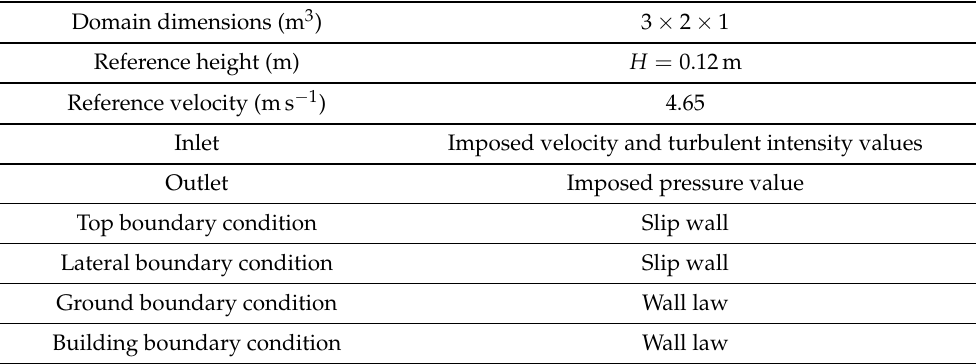
Table 3. Model settings for the street canyon dispersion case.